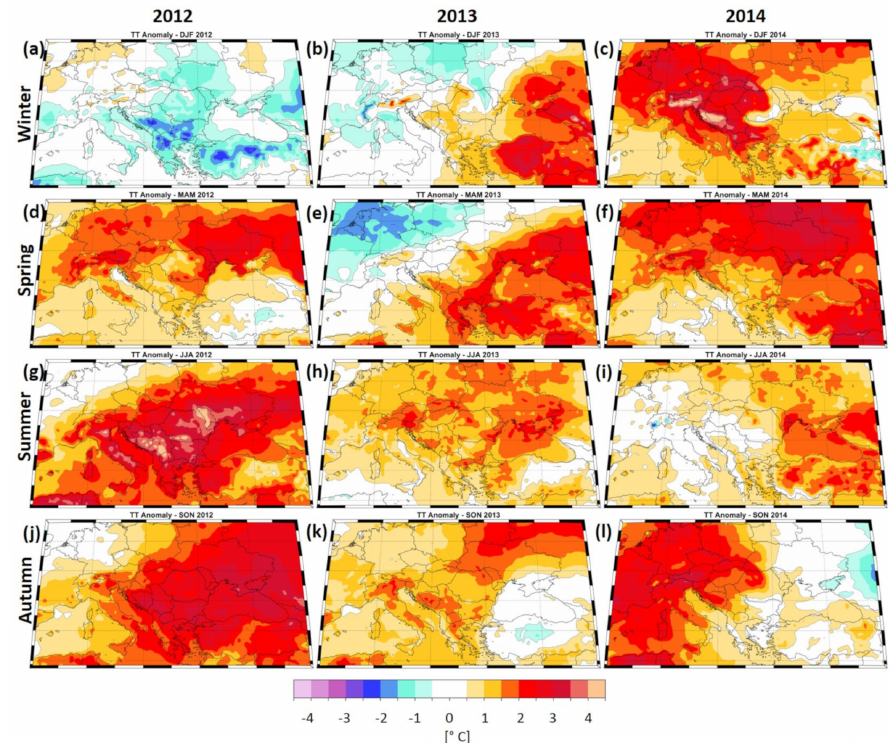
Figure 7. The spatio-temporal distribution of the seasonal mean air temperature anomalies over the period of January 2012 to December 2014. The anomalies are computed relatively to the climatological period 1971–2000.